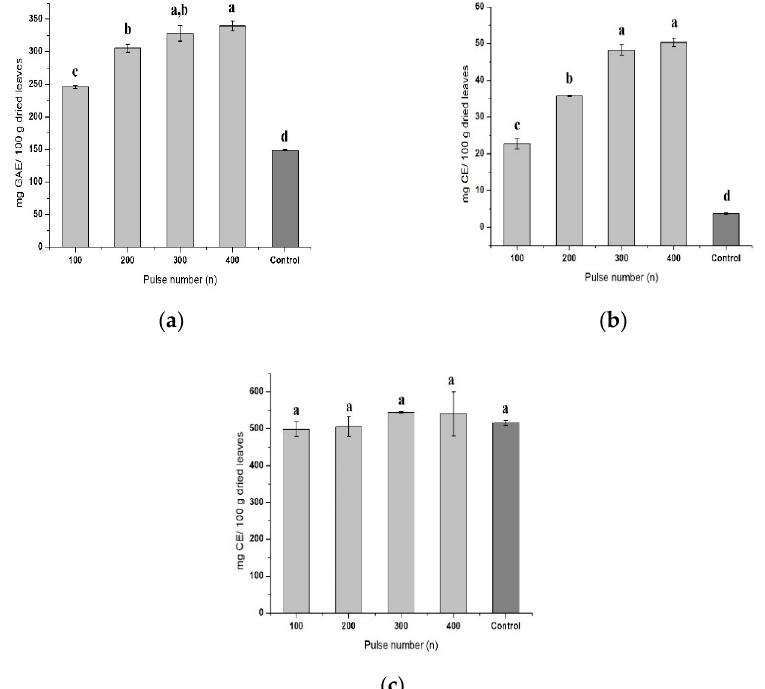
Figure 3. Variation of the phenolic compound extraction yield as a function of the pulse number. ( a )Total phenolic content; ( b )Total flavonoid content; ( c ) Condensed tannin content. Means not sharing any letters are significantly different.